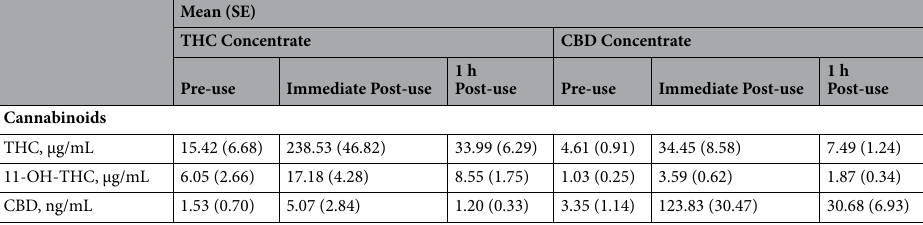
Table 3. Means and standard errors of cannabinoid plasma level by timepoint and treatment group. THC, tetrahydrocannabinol; 11-OH-THC, 11-hydroxy-Δ9-THC; CBD,